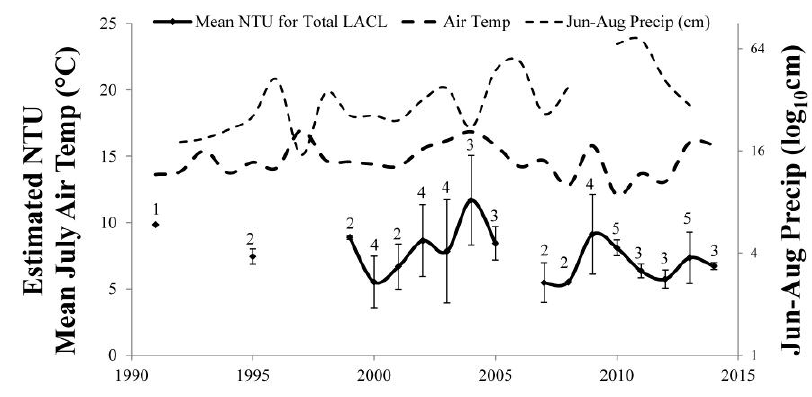
Figure 5. Trend in mean annual estimated turbidity (NTU E ) for the entirety of Lake Clark, based on full-extent scenes (n = 53). Error bars represent standard deviations. Numbers represent sample sizes of contributing scenes for each year. Recorded mean July air temperature and mean June–August precipitation are reported as potential drivers of variation in